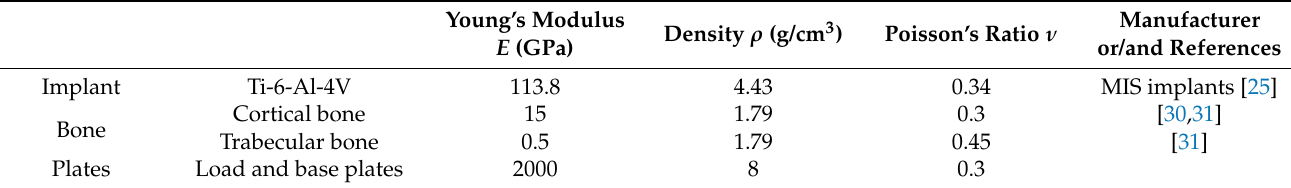
Table 4. Mechanical properties of the implant, bone and plates.